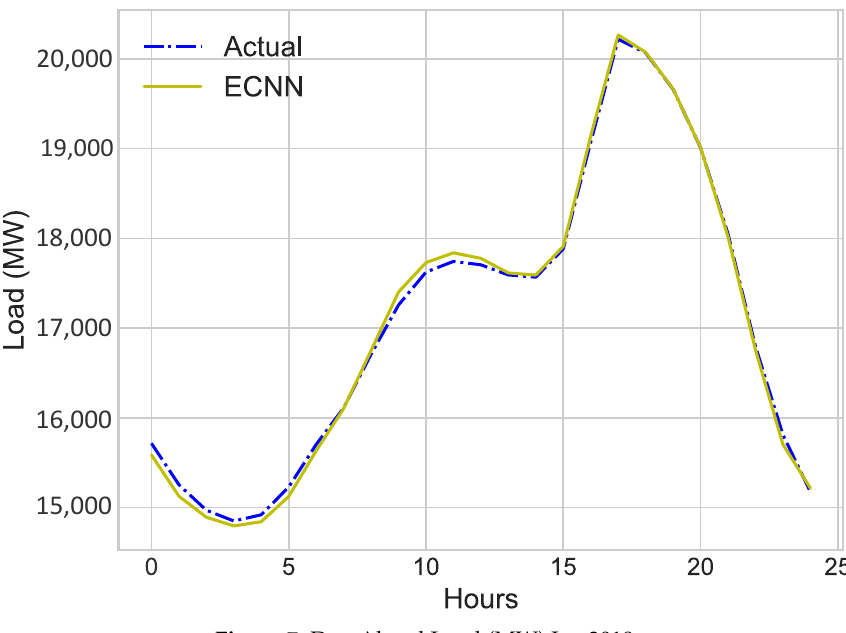
Figure 7. Day-Ahead Load (MW) Jan 2018.